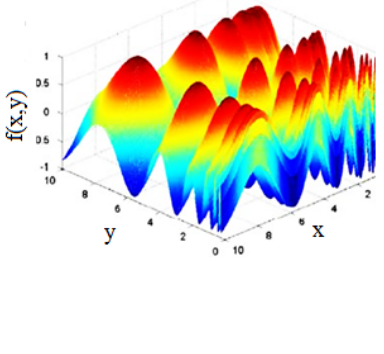
Figure 7: Inverted Vincent